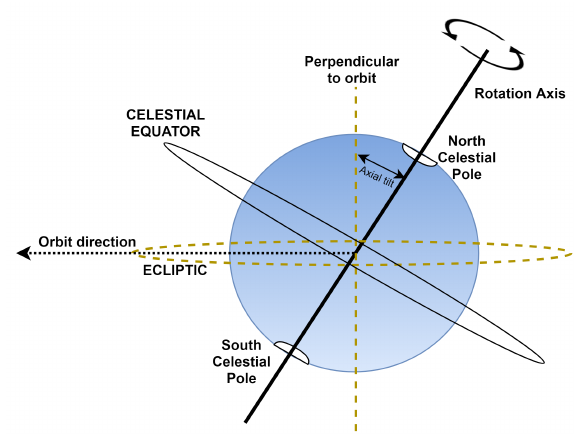
Figure 4. Rotational axis, perpendicular- to-orbit axis, and axial